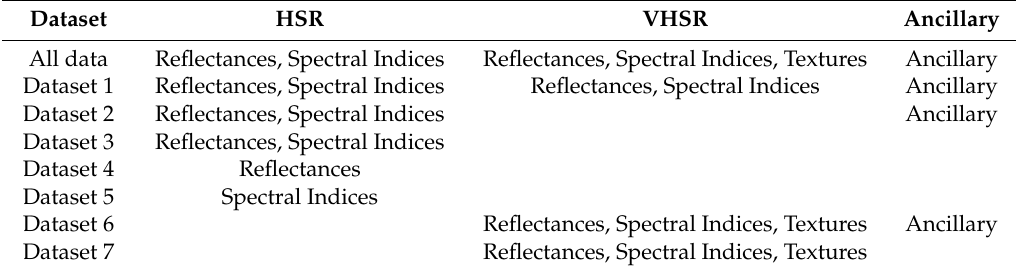
Table 3. Definitions of the experimental datasets used to analyze contributions of the different sources (high spatial resolution imagery (HSR), very high spatial resolution imagery (VHSR), and ancillary) and types (reflectances, spectral indices, textures, and ancillary) of data on the accuracy of the classifications.